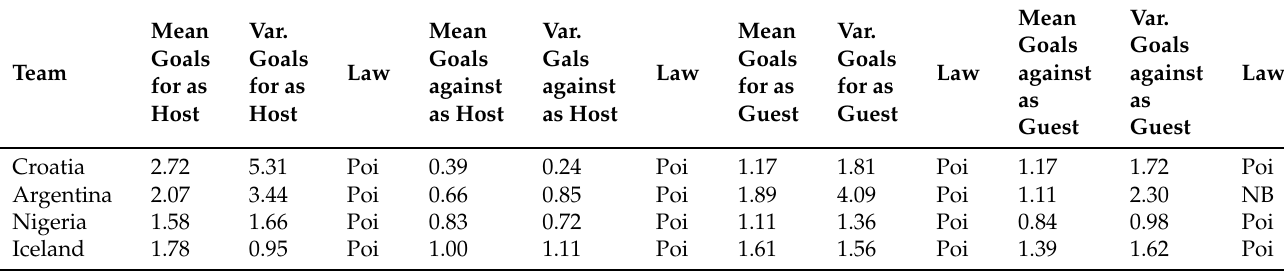
Table 9. Group D in Russia